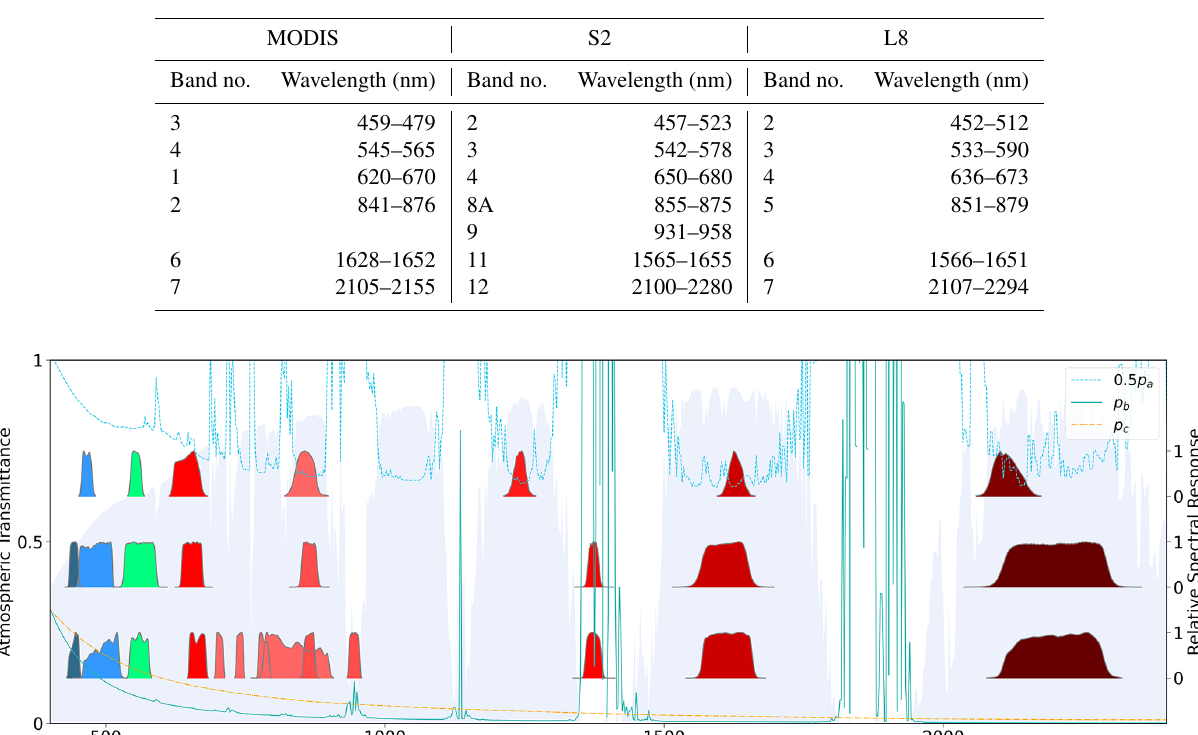
parameters for relative day d